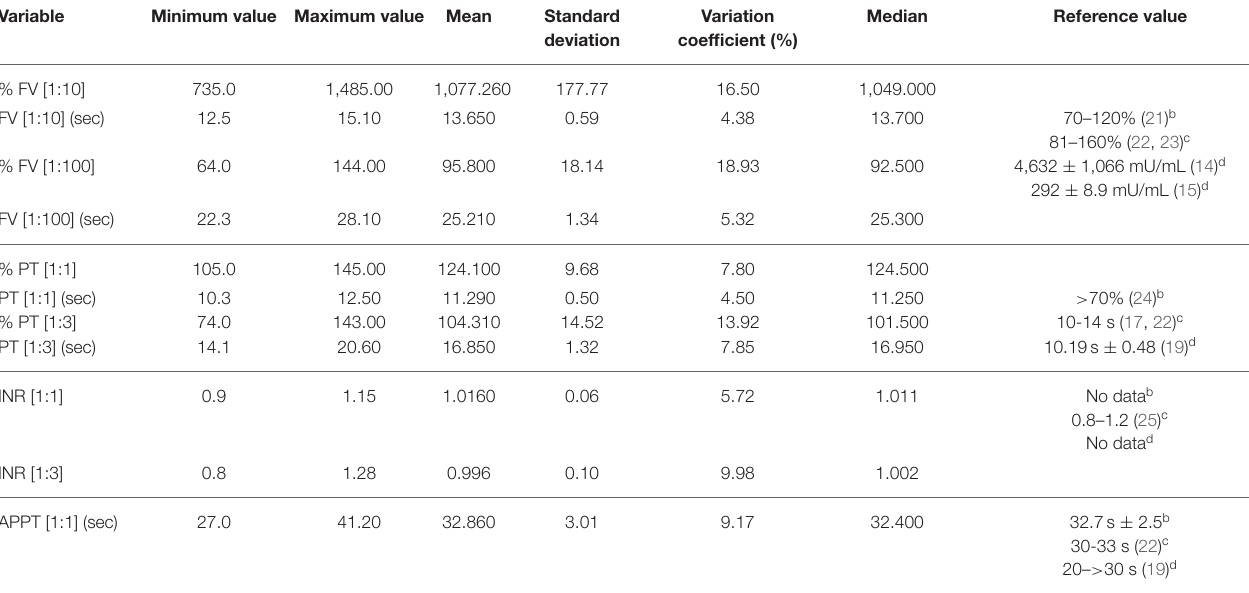
TABLE 3 | Measurements a of factor V, prothrombin time, International Normalized Ratio (INR) and activated partial thromboplastin time.